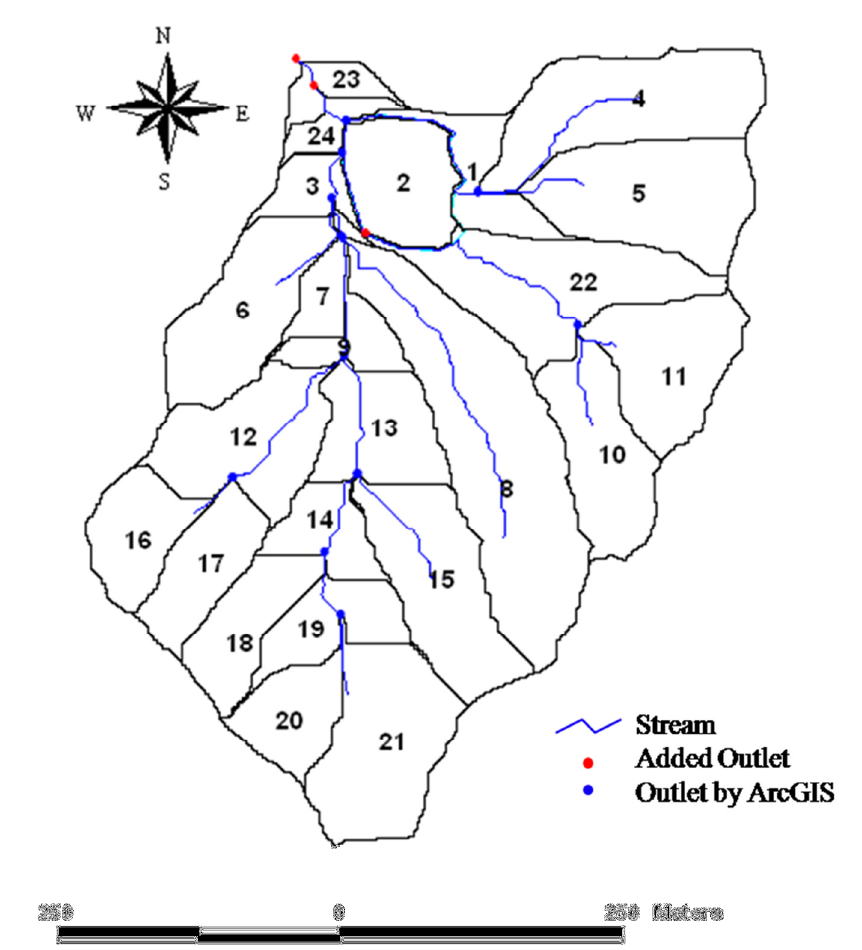
Figure 9. Subwatersheds Delineated for Simulation of Diversion